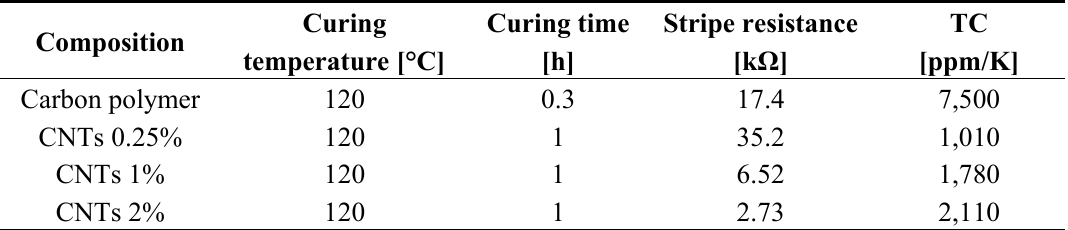
Table 2. Electrical and thermal properties of elaborated thick film stripes.